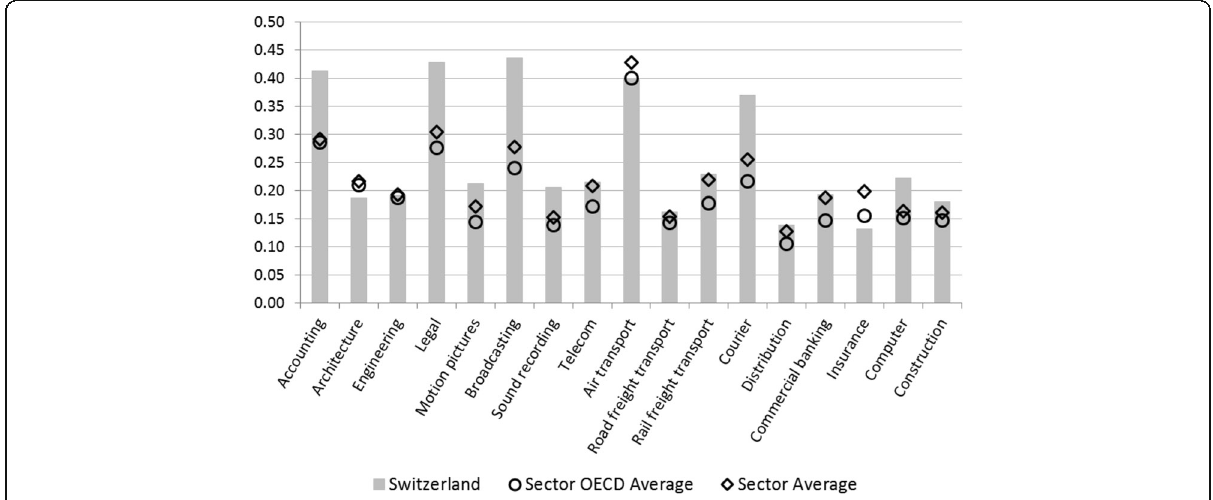
Fig. 13 Services Trade Restrictiveness Index for Swiss service sectors. Source: OECD